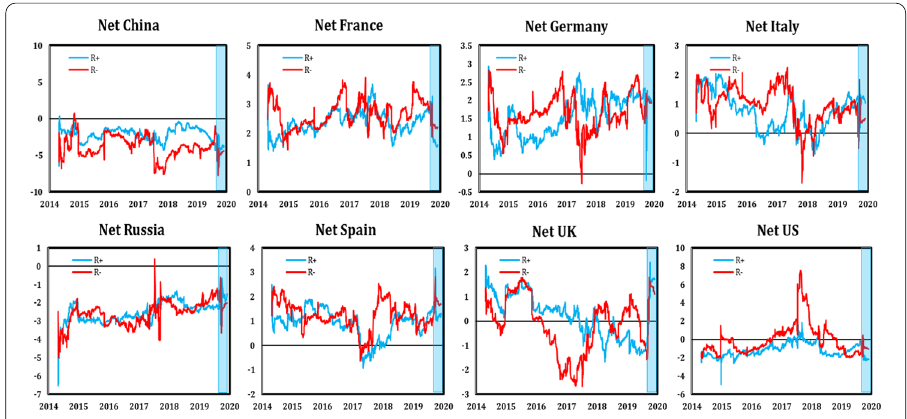
Fig. 7 Net dynamic spillover of positive (R the period of the COVID-19